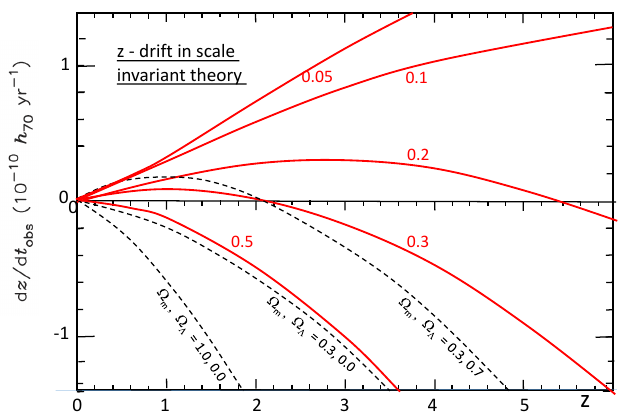
Figure 8. The drifts of redshifts dz / dt as a function of redshift in the scale invariant theory (red curves). The values of Ω m (usual definition) are indicated. The black broken lines give the results for some standard models of different couples ( Ω Λ , Ω m ) by Liske et al.